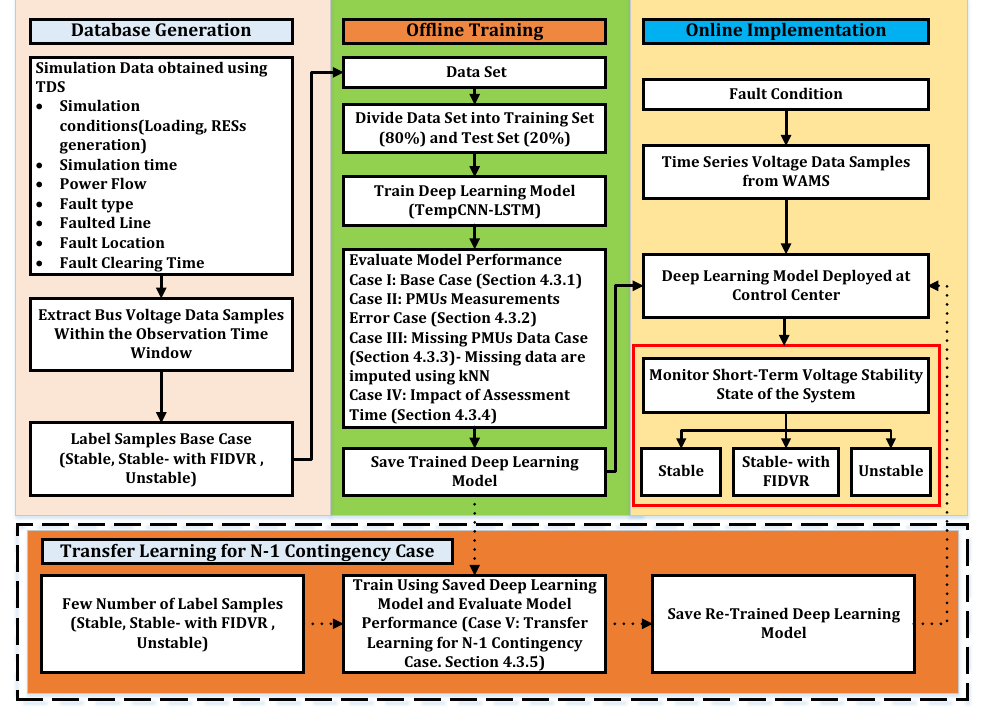
Figure 2. Proposed framework for STVS assessment.